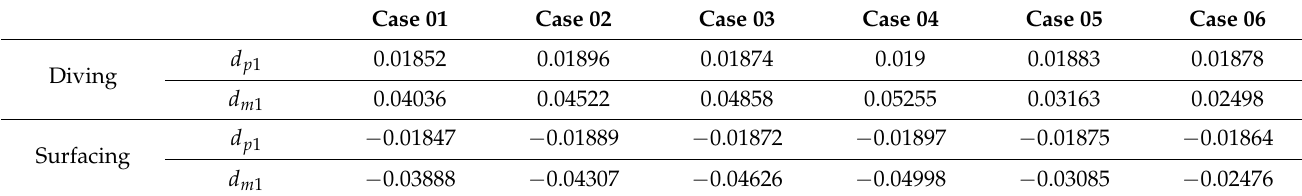
Table 4. Parameters of d m 1 and d p 1 for Case 01-Case 06 (units: m).